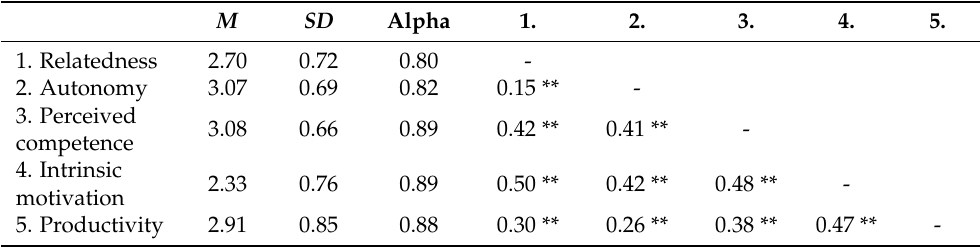
Table 1. Average scores, standard deviations, and correlations (N =